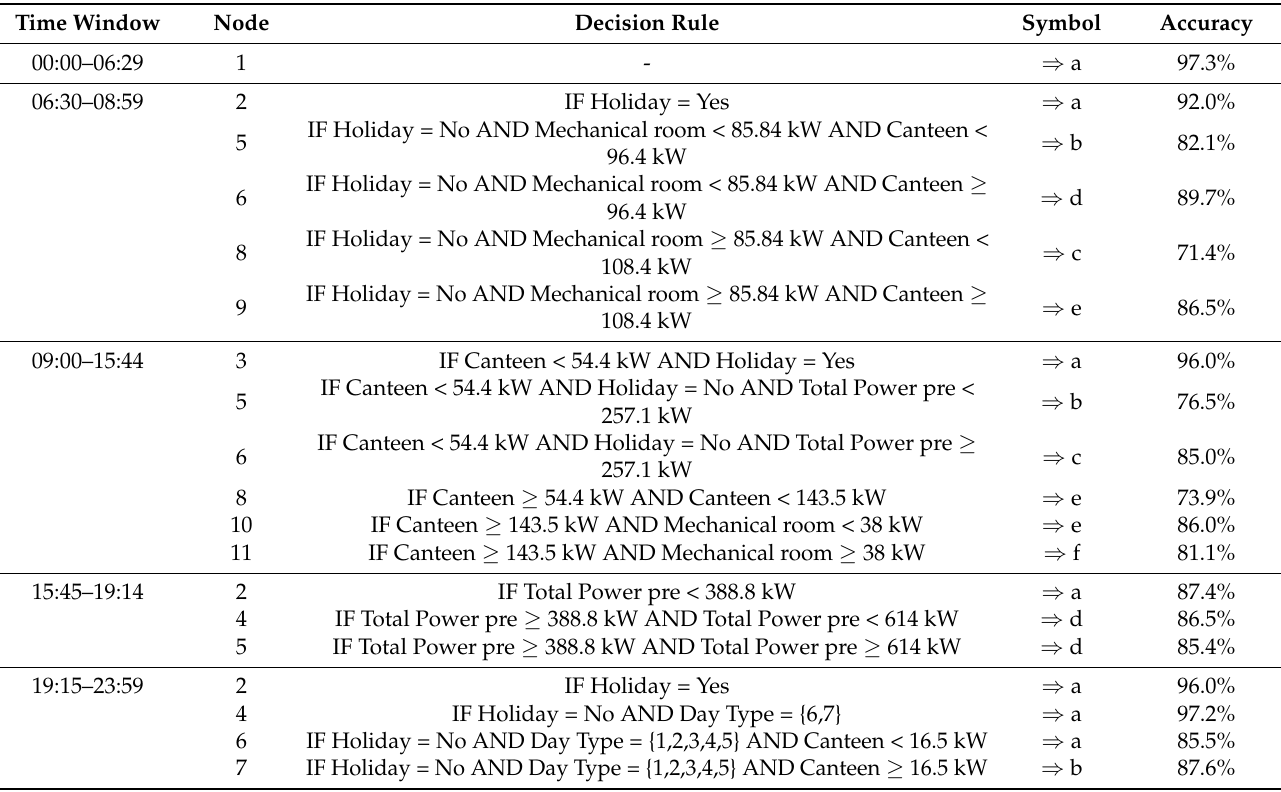
Table 2. Decision rules extracted from globally optimal trees created in each time window on the training period. Time Window Node Decision Rule